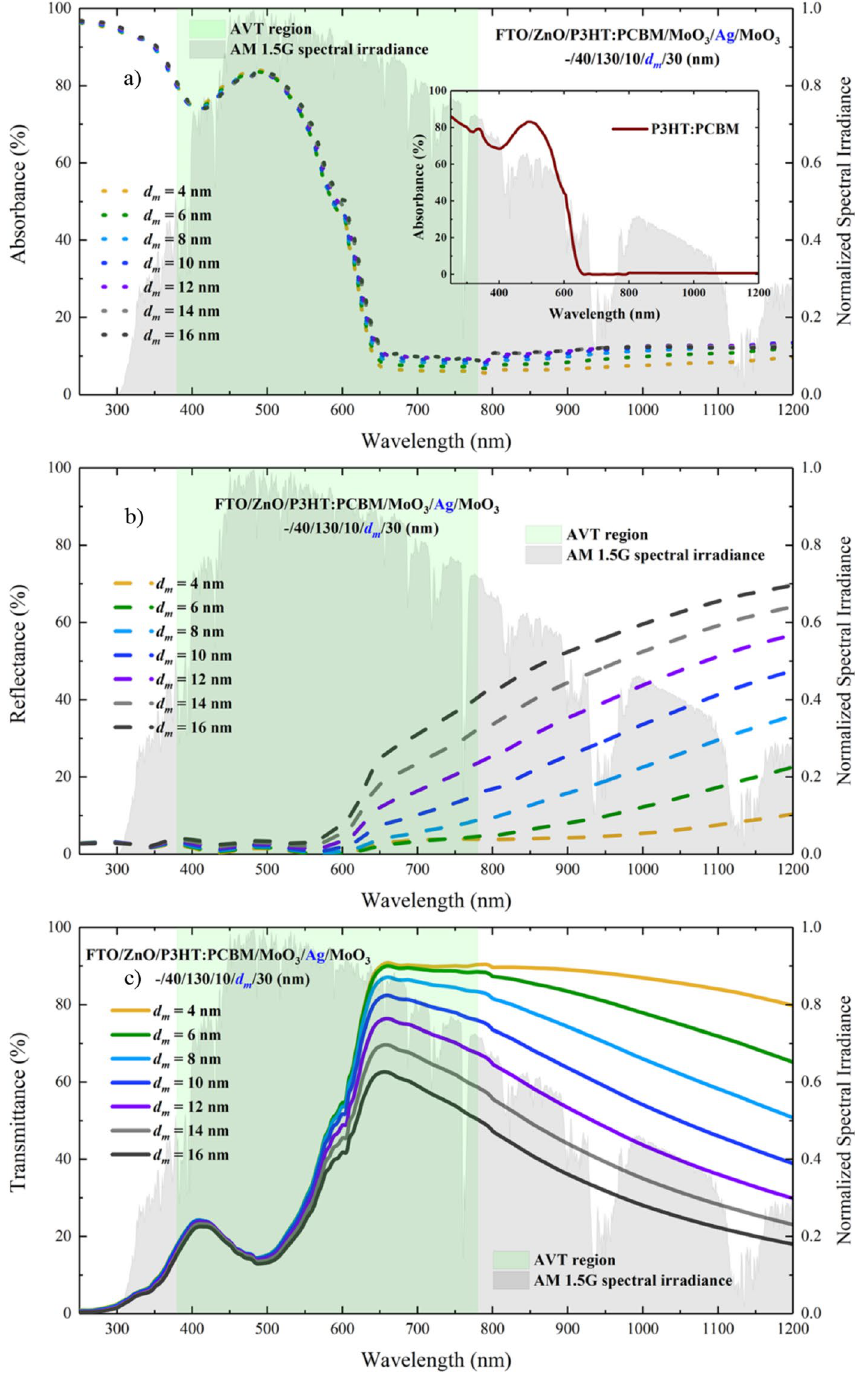
Figure 4. For FTO/ZnO/P3HT:PCBM/MoO 3 /Ag/MoO 3 (–/40/130/10/ d m /30 nm) ST-OSC; ( a ) absorbance, ( b ) reflectance and ( c ) transmittance spectra. ( a ) Shows the absorbance spectrum of the P3HT:PCBM polymer blend that forms the active area of the inset